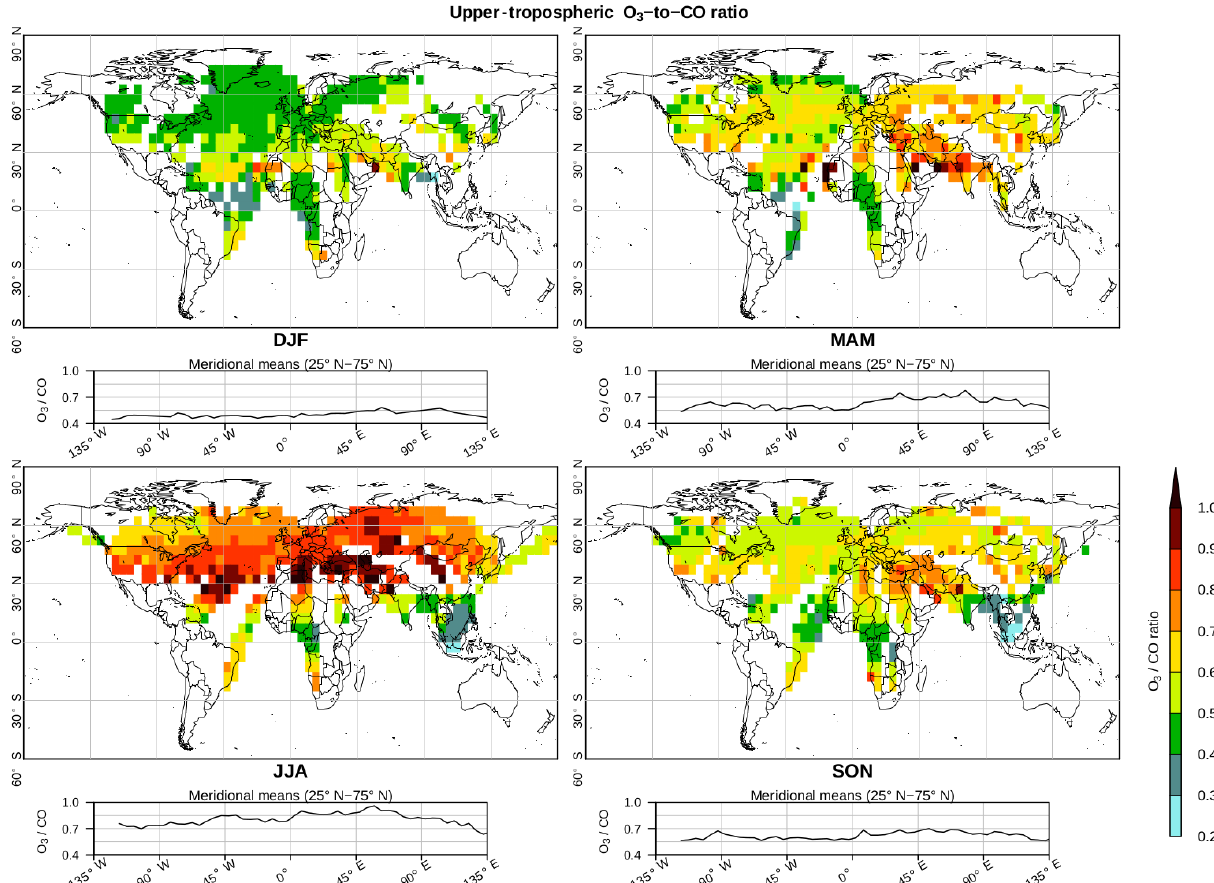
Figure A1. Horizontal distributions of the O 3 -to-CO ratio in the UT averaged from December 2001 to November 2013, in every season. Each 2-D distribution is projected onto the zonal axis below, with a meridional average of the northern extratropical zonal band (from 25 to 75 ◦ N). The 2-D (1-D) distributions have a 5 ◦ × 5 ◦ (5 ◦ ) resolution. The x axes are the same in the maps and in the projections